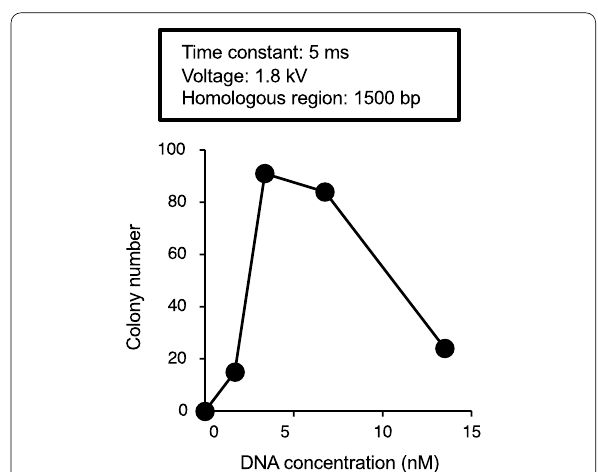
Fig. 3 Effect of the DNA concentration for gene transfer by electroporation in T. asahii . The DNA fragment 2 (0–13.5 nM) was added to competent T. asahii cells prepared by culture for 1 day and electroporated (time constant protocol: 1.8 kV, 5 ms). The number of colonies grown on SDA containing nourseothricin (300 µg/ml) was